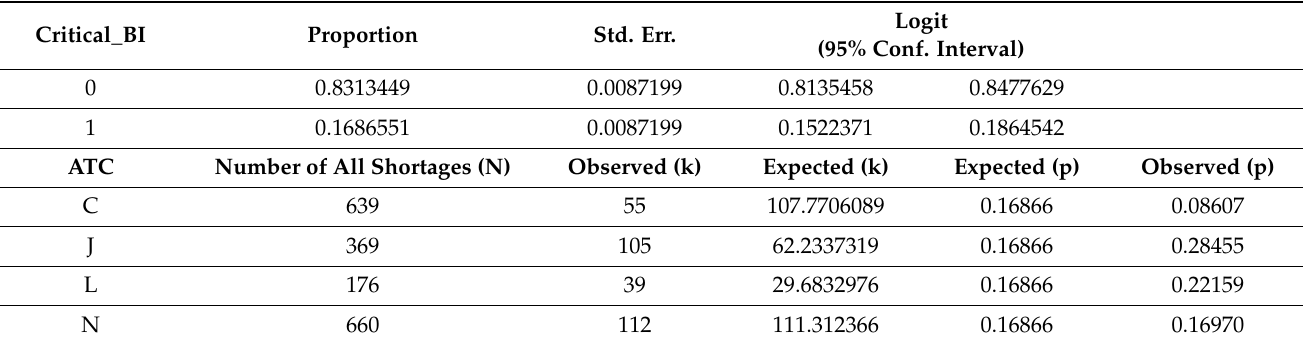
Table 4. Proportion estimation of critical shortages over the whole dataset. Binomial probability tests of proportion of critical shortages across ATC